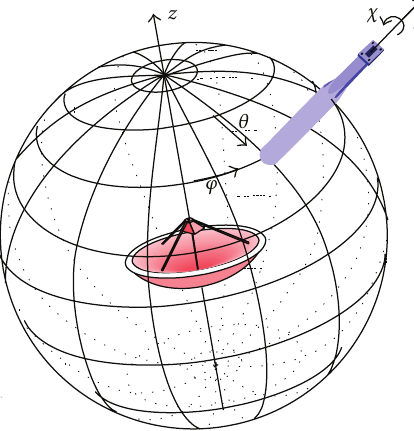
Figure 1: External spherical